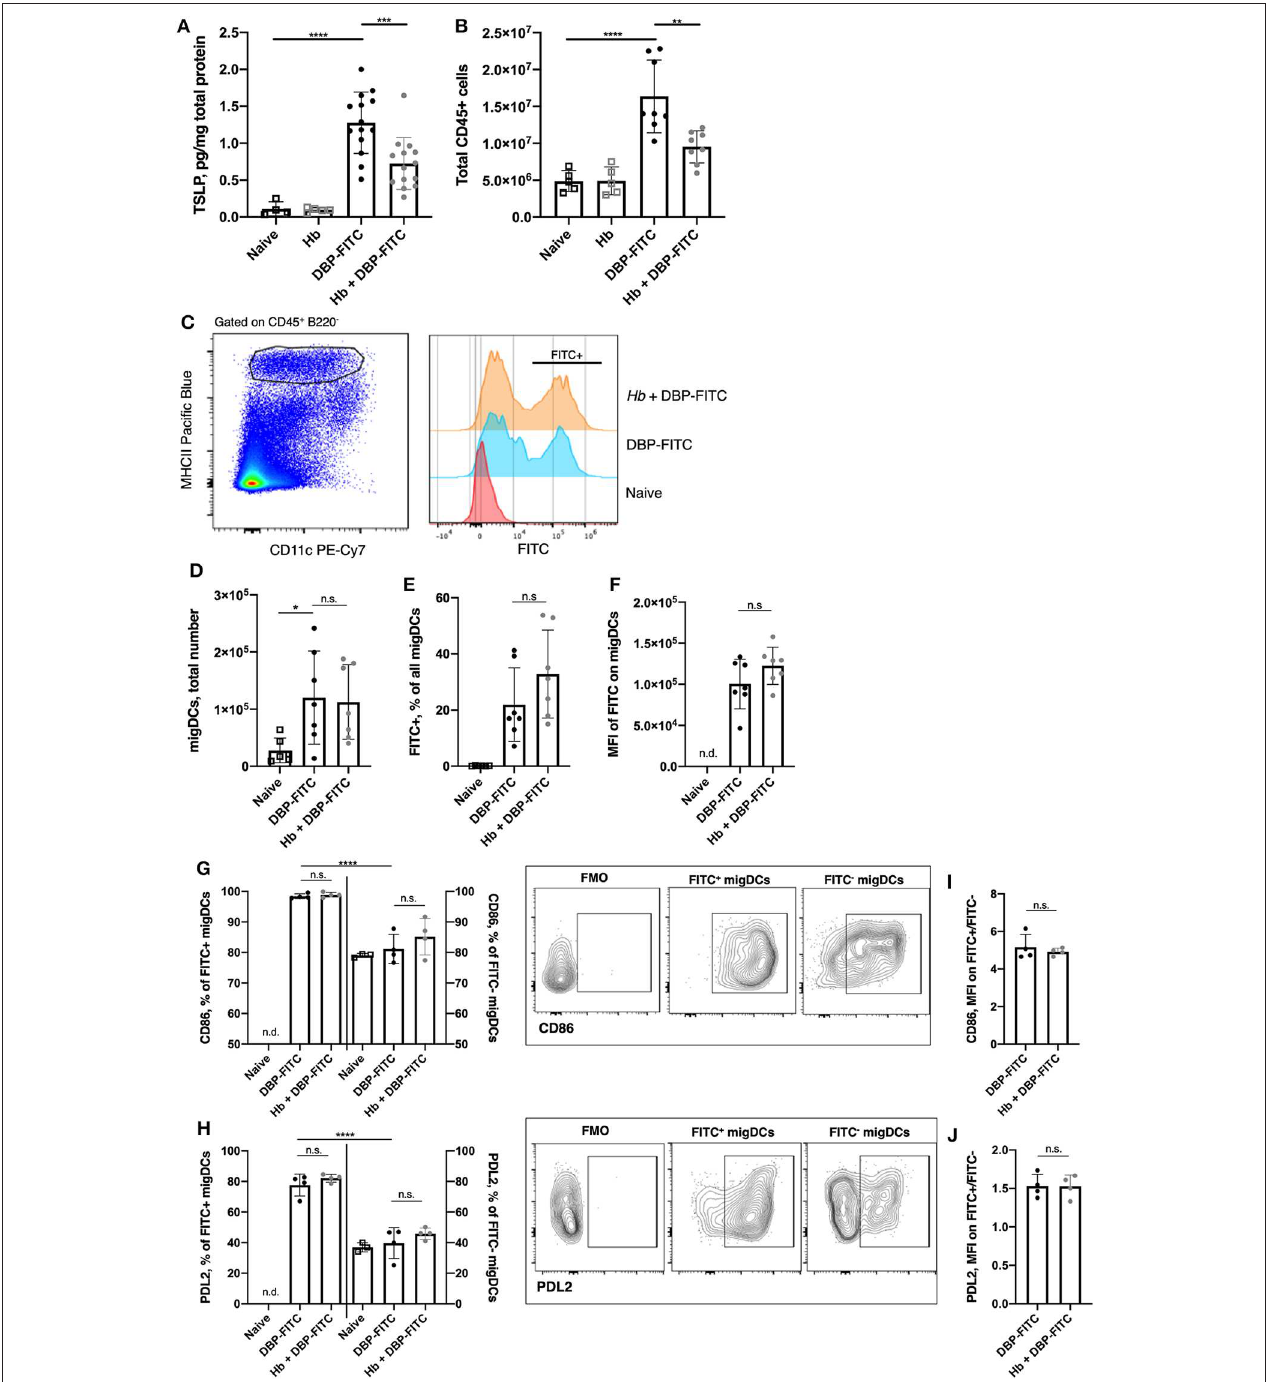
FIGURE 3 | H. bakeri infection does not affect DC uptake and transport of DBP-FITC to the skin draining LN after sensitization. (A) TSLP protein levels 24h post-sensitization with DBP-FITC in tissue lysate measured by ELISA. (B) Total number of live CD45 + cells in the ear dLN at 2 days post DBP-FITC sensitization. (C) Representative plots of FITC expression by CD45 + B220 − CD11c var MHCII high migratory DCs (migDCs) in the ear dLN at day 2. (D) Total number of migratory DCs (migDCs) in the ear dLN at day 2. (E) Frequency of FITC + migDCs in ear dLN at day 2. (F) Median fluorescence intensity (MFI) of FITC on migDCs in the ear dLN at day 2. (G) Frequency of FITC + and FITC − DCs expressing CD86 or (H) PDL2 in the ear dLN at d2, with plots showing representative gating. (I) Ratio of MFI of CD86 or (J) PDL2 expression in FITC + vs. FITC- migDCs in the dLN at d2. A one-way ANOVA with Tuckey’s multiple comparisons test was used to test statistical significance between multiple groups (A–H) , or an unpaired t -test between 2 groups (I,J) . FMO, fluorescence minus one. Graphs represent data combined from 2 experiments (A–F) or are representative of 2 repeat experiments (G–J) . Graphs show mean ± SD. n.s, not significant; * p < 0.05, ** p < 0.01, *** p < 0.001, **** p < 0.0001. n.d, not